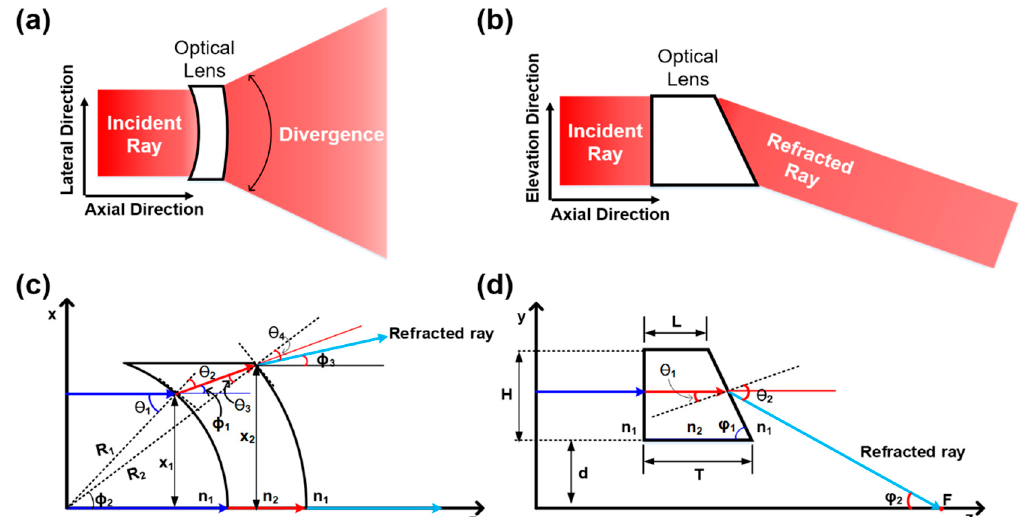
Figure A1. Conceptual illustration of the desired optical lens in ( a ) the lateral-axial plane and ( b ) elevation-axial plane. The models for divergence and refraction in the lens are shown in ( c , d ), respectively.